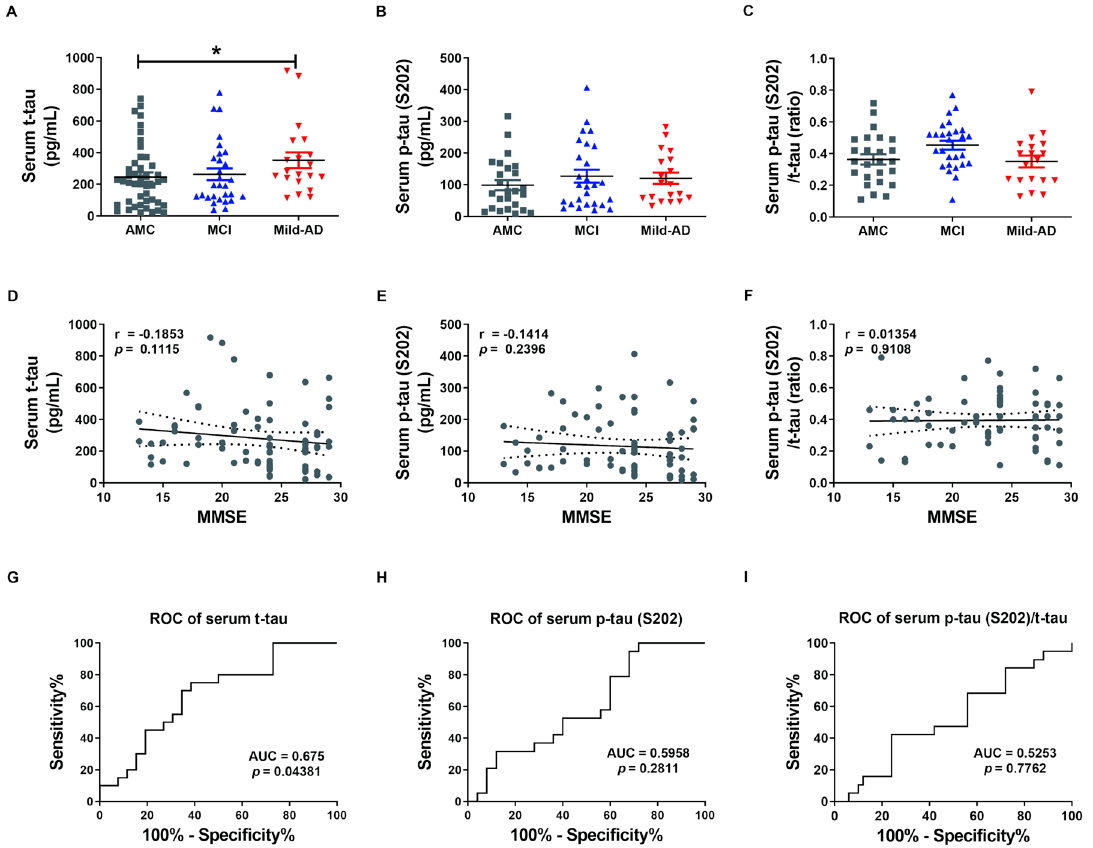
Figure 1. Elevated serum total tau (t-tau) protein in patients with mild Alzheimer’s disease (AD). ( A ) Total tau (t-tau), ( B ) phosphorylated (p)-tau (S202), and ( C ) p-tau (S202) / t-tau ratio in human serum were quantified using ELISA. Serum t-tau was higher in the Mild-AD group compared to the age-matched control (AMC) group. All data were shown as means ± SEM. * p < 0.05 compared to the AMC group by one-way ANOVA and post hoc Dunn’s multiple comparison test. Correlations of serum ( D ) t-tau, ( E ) p-tau (S202), and ( F ) p-tau (S202) / t-tau with Mini-mental state examination (MMSE) scores were assessed by the nonparametric Spearman’s rank correlation test. Graphs show regression lines with 95% confidence intervals. Serum t-tau was significantly correlated with MMSE scores. Receiver operating characteristic (ROC) analyses of serum ( G ) t-tau, ( H ) p-tau (S202), and ( I ) p-tau (S202) / t-tau. ROC analysis revealed moderate diagnostic accuracy of elevated serum t-tau. AUC, area under the